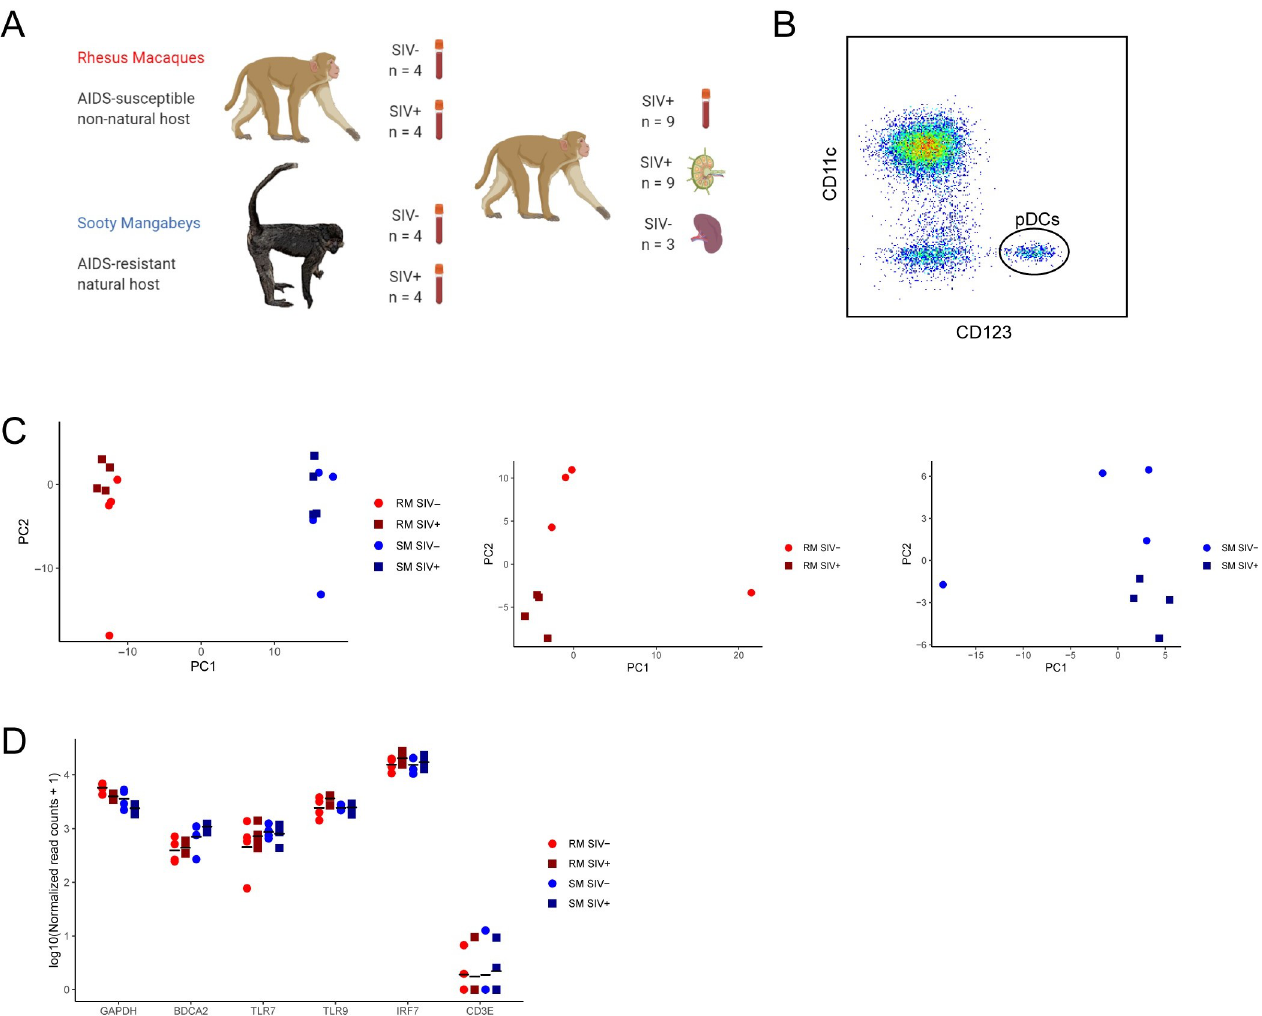
Fig 1. Overview of comparative transcriptomics of pDCs in SIV infection. (A) Summary of the samples used to compare the transcriptomes of pDCs sorted from peripheral blood in SIVsmm infected sooty mangabeys and SIVmac239 infected rhesus macaques or compare the transcriptomes of pDCs sorted from the peripheral blood and lymph nodes of SIVmac239 infected rhesus macaques. No animals were on ART. (created with BioRender.com). ( B ) Representative flow plot of sorting strategy to obtain pDCs from PBMCs, based on CD11c and CD123. ( C ) Principal component analyses (PCA) of transcriptome from pDCs, with SIV- RMs shown as red circles, SIV+ RMs as red squares, SIV- SMs as blue circles, and SIV+ SMs as blue squares. ( D ) Normalized read counts (log10) for four representative genes with known expression in pDCs and a housekeeping gene, GAPDH. The normalized read counts of the CD3E gene, which is primarily expressed primarily by T lymphocytes, is also included to show background read count levels. Dots show read counts for individual animals and black lines show mean normalized read counts (log10) of n = 4 for each experimental group.